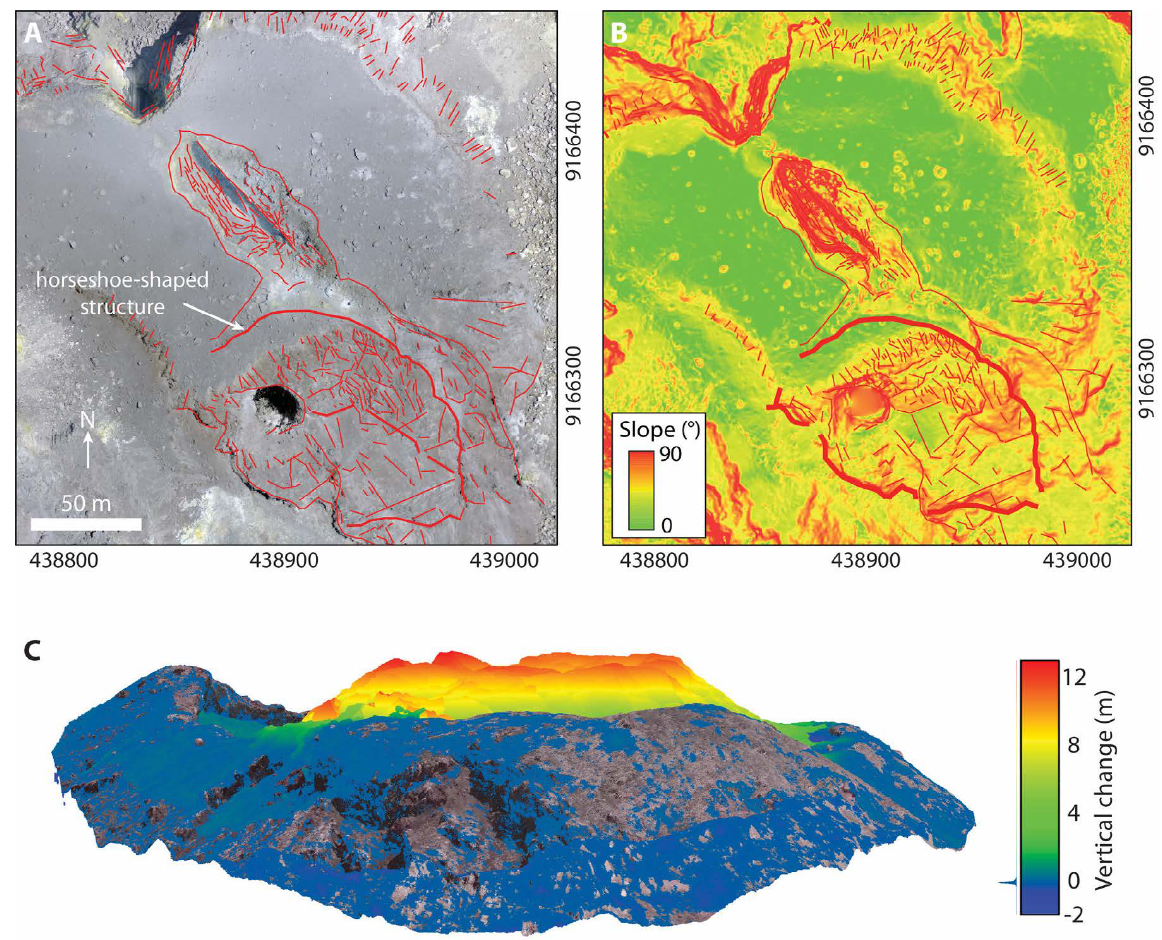
Figure 8: Lava domes surveyed by UAS. [A] and [B] The lava dome at Merapi, as mapped by combined UAS and TLS surveys (October 2015), showing a flat summit region, with highly fractured central fissure area, dome margins and southern flank. Red lines denote fractures and visible lineaments, and coordinates are in UTM. [A] Photomosaic of imagery collected by a DJI Phantom quadrotor from a height of 140 m above the ground. [B] Slope map from a 0.5-m-resolution DEM. The horseshoe-shaped structure bounds a fractured, southern-sloping region (descending >80 m at the map boundary) for which repeat UAS imaging in 2017 identified mechanical weakening, due to hydrothermal alteration at its northern boundary. Adapted from Darmawan et al. [2018b]. [C] Dome growth of Volcán de Fuego, captured by repeat flights of a DJI Phantom 3 Pro quadrotor in 2017 [Watson et al. 2017]. The oblique view shows two SfM-photogrammetry point clouds of the growing dome in the summit crater derived from imagery acquired on 19 (in true colour) and 23 (coloured by vertical change) February; the flat dome surface is approximately 40 m across. With GCP deployment not possible, the surveys were georeferenced using GNSS information embedded in the image metadata and their relative registration then refined using regions of unchanged surface on the